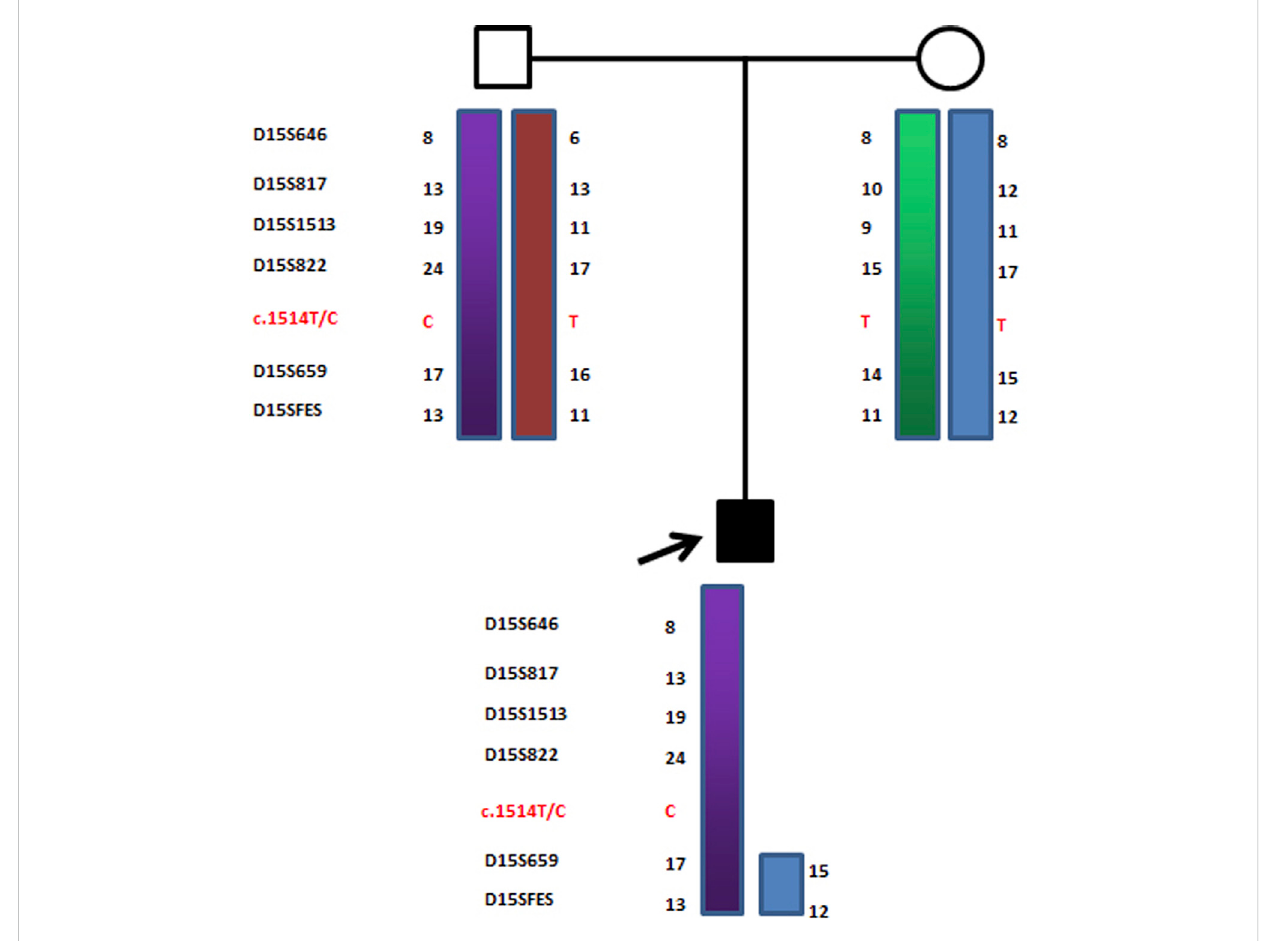
FIGURE 7 Photograph of proband 2 at 50 days. He was diagnosed as OCA2 with